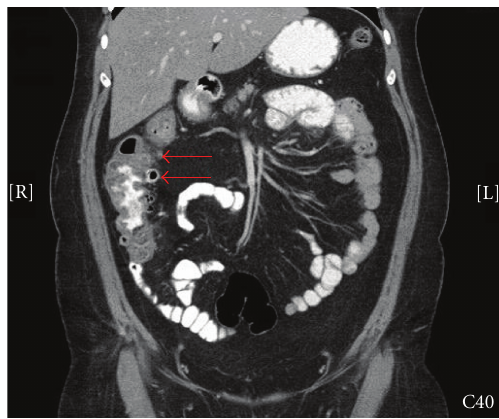
Figure 2: Coronal CT image demonstrating right-sided colonic